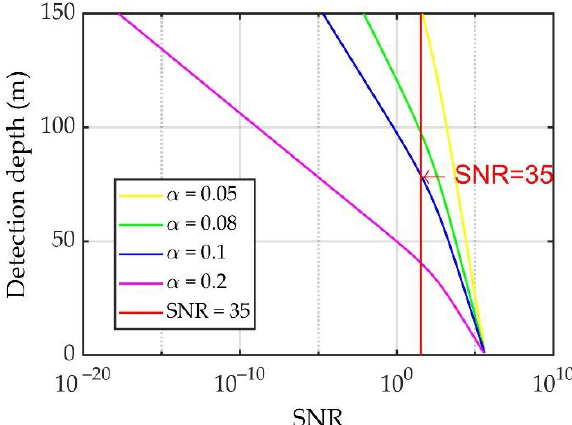
Figure 17. Effective detection depth under different water attenuation coefficients.